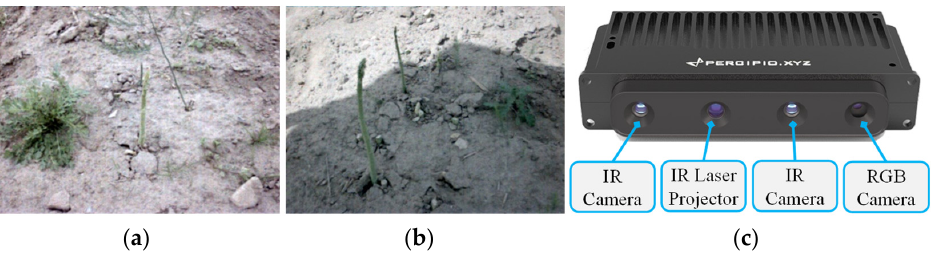
Figure 1. Examples of captured images of green asparagus using Tuyang FM810 Camera: ( a ) Green asparagus in a weedy environment. ( b ) Green asparagus in shade. ( c ) Front view of the camera.